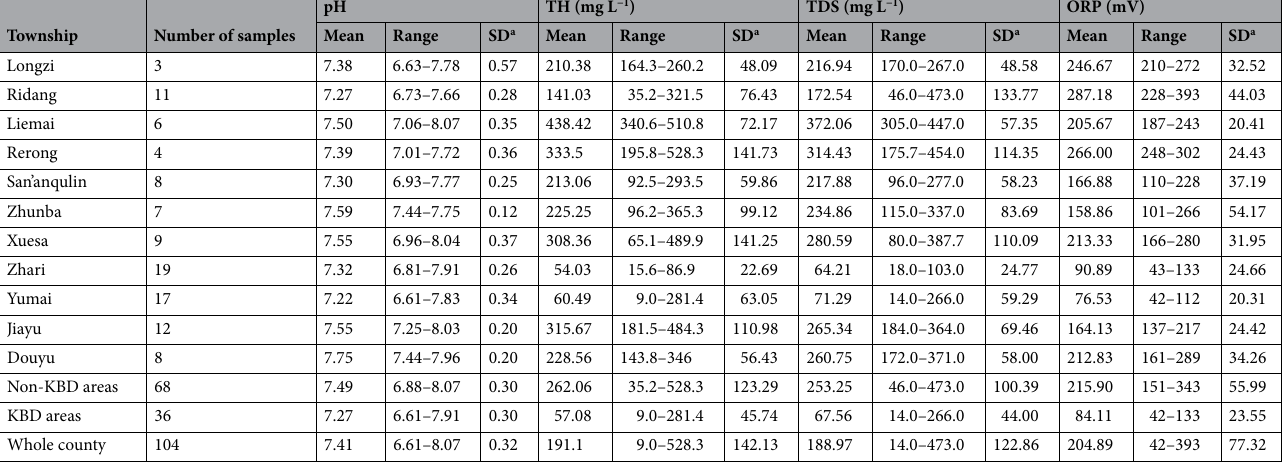
Table 1. Summary of pH, TH, TDS and ORP data for surface water samples from different townships in the Longzi County. a Standard deviation